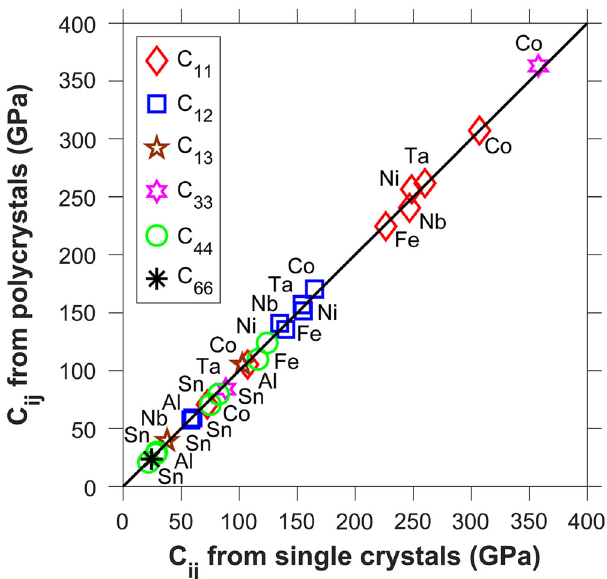
Fig. 5 Comparison of the elastic constants measured from polycrystalline Al, Co, Fe, Nb, Ni, Sn, and Ta samples using ultrafast laser-generated SAWs with those reported in the literature measured from single crystals. The single crystal data are from refs. 28 –